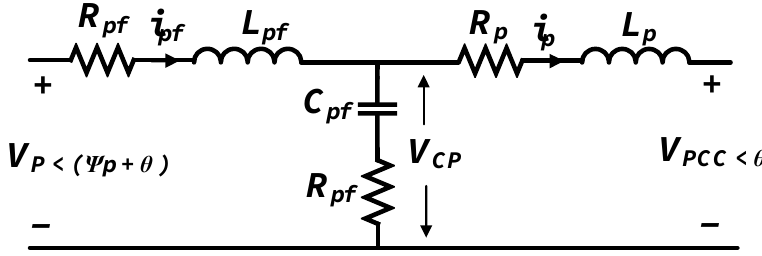
Figure 6. The inductance–capacitance (LC) filter and transmission line model.